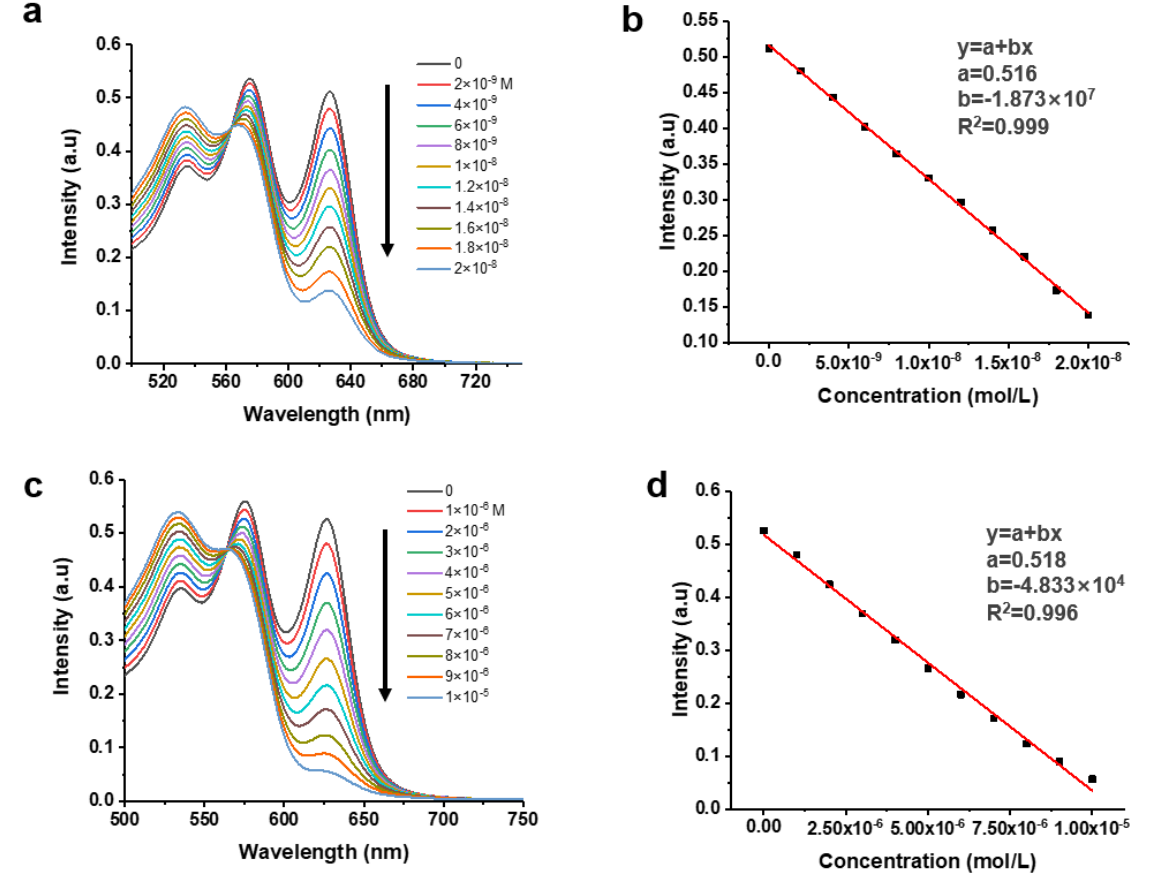
Figure 6. ( a ) Alternations of the UV–vis spectral of C-dots (10 µ g/mL) in presence of pyridine solutions of different concentrations. ( b ) Calibration curve showing the linear relationship between the absorption intensities of C-dots at 626 nm and the concentrations of pyridine. ( c ) Alternations of the UV–vis spectral of C-dots (10 µ g/mL) in presence of lysine solutions of different concentrations. ( d ) Calibration curve showing the linear relationship between the absorption intensities of C-dots at 626 nm and the concentrations of lysine.